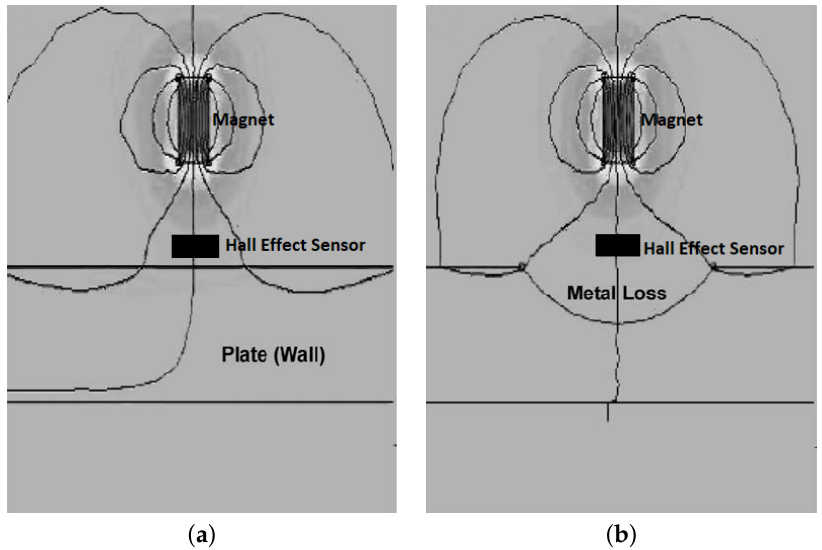
Figure 26. ( a ) Magnetisation of the wall of a pipeline using weak magnetic fields. ( b ) The measure- ment of the small changes in the magnetic field strength using Hall effect sensors. Reprinted from NDT & E International, Volume 42, Gloria, N.B.S.; Areiza, M.C.L.; Miranda, I.V.J.; Rebello, J.M.A. Development of a Magnetic Sensor for Detection and Sizing of Internal Pipeline Corrosion Defects, Page 669–677, Year 2009 with permission from Elsevier